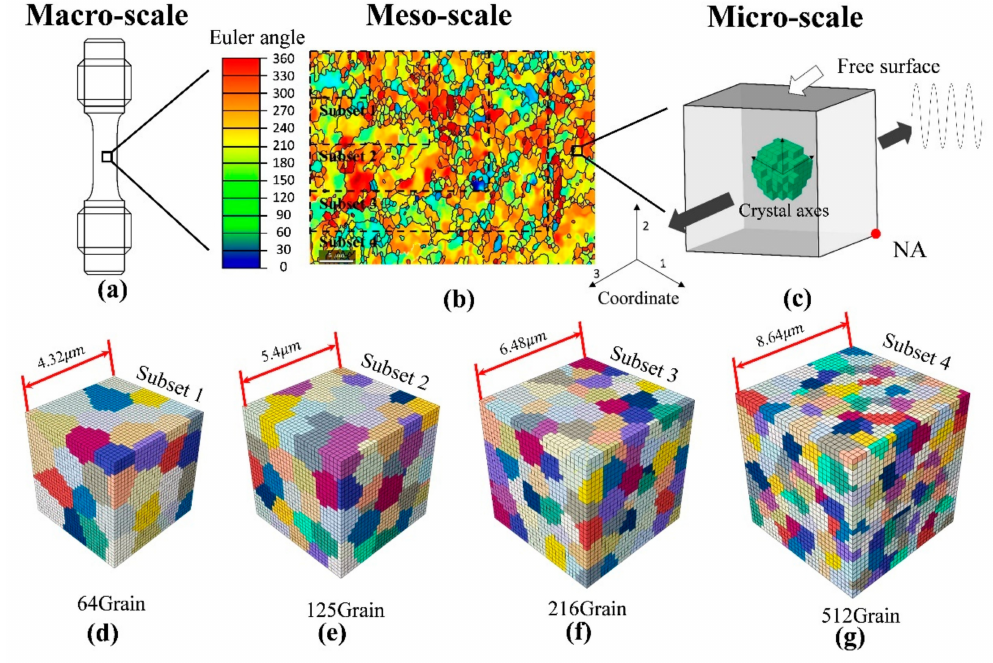
Figure 4. ( a ) The tested LCF specimen; ( b ) EBSD map; ( c ) boundary condition and loading direction applied to RVE; ( d ) Subset1-64grains; ( e ) Subset2-125grains; ( f ) Subset3-216grains; ( g ) Subset4-